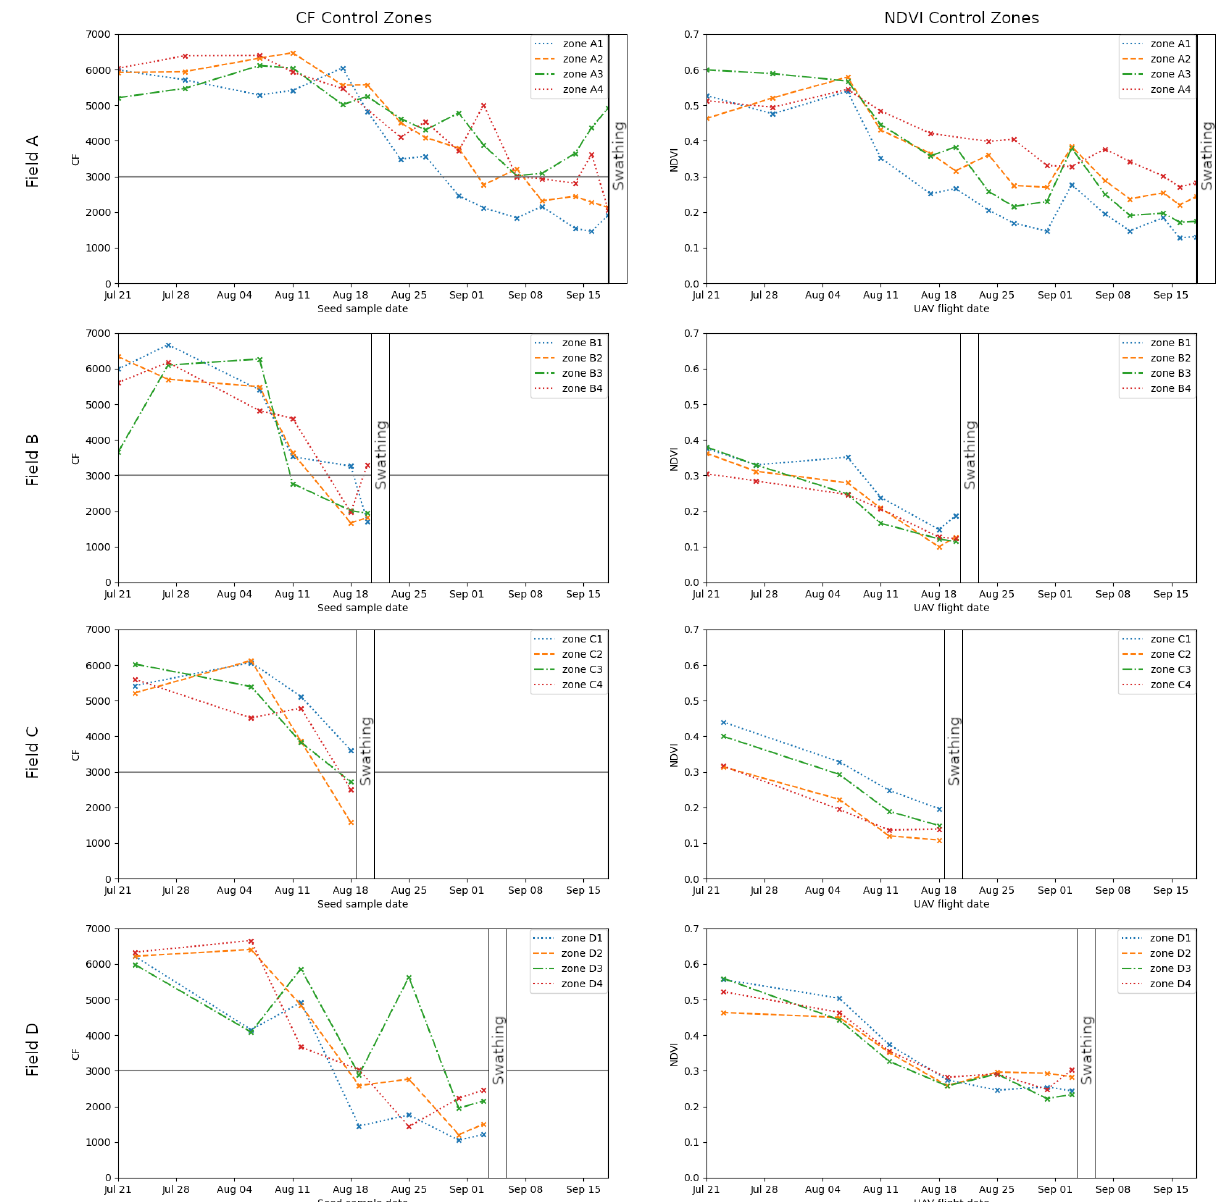
Figure 3. In the left column, the chlorophyll fluorescence (CF) evolution over time of the ground truth seed samples for Fields A, B, C, and D. In the right column, the associated NDVI evolutions of the control zones computed from the UAV multispectral images until the field swathing